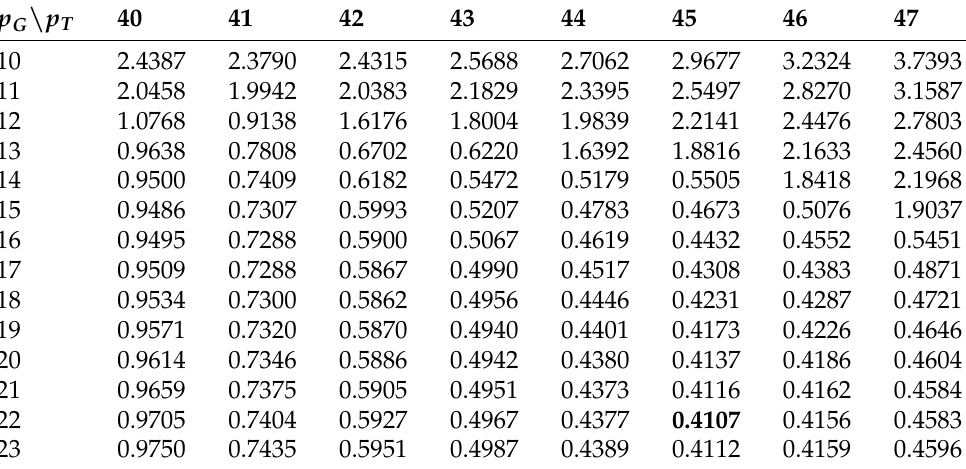
Table 2. MPC tuning (ISE) ( × 10 − 2 ) in function of the turbine’s ( p T ) and generator’s ( p G ) QDMC controller’s prediction horizon.